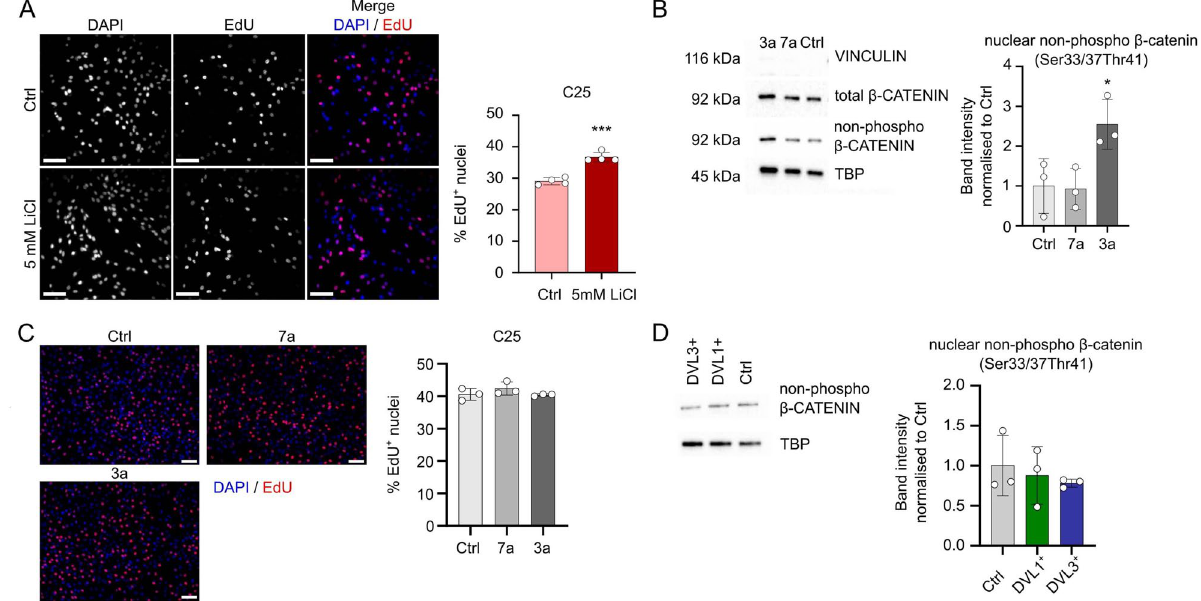
Figure 5. DVL-enhanced proliferation does not operate through β-CATENIN. ( A ) Representative images of proliferating C25 myoblasts after stimulation with 5 mM LiCl for 24 h showing incorporated EdU (red), with all nuclei counterstained with DAPI (blue). Scale bar represents 100 µm. Quantification was performed for 4 biological replicates, and significant difference was assessed using a student’s T-test. Three asterisks indicates p < 0.001. ( B ) Quantification of western blot for total β-CATENIN and non-phosphorylated active β-CATENIN in nuclear fractions of proliferating C25 myoblasts stimulated with WNT ligands WNT7a or WNT3a for 24